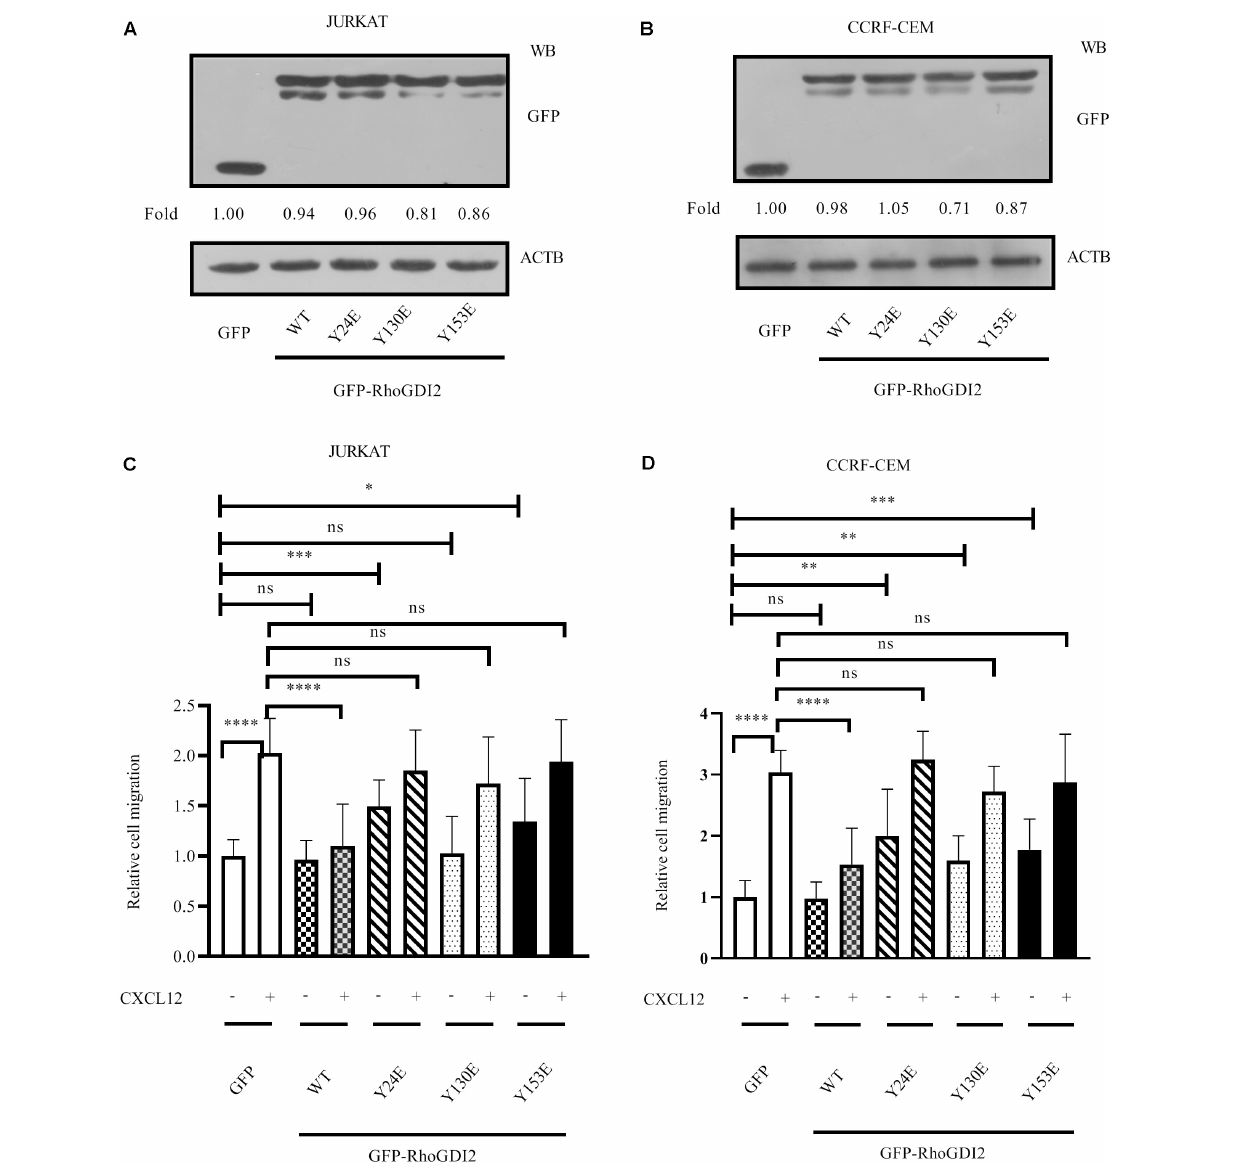
FIGURE 3 | Phosphorylation of RhoGDI2 Tyr 24, 130, or 153 recovered CXCL12-mediated ALL migration. JURKAT (A) or CCRF-CEM (B) cells were infected with lentivirus containing nucleotides expressing GFP-RhoGDI2-WT, Y24E, Y130E, or Y153E, and the overexpression levels of WT or mutated RhoGDI2 were detected 48 h after infection by Western blot, using GFP antibody. (C,D) Transfected cells were used in the transwell assay. Each experiment was repeated at least three times. Western blot bands were analyzed using Image Pro Plus 6.0, and fold changes of GFP, GFP-RhoGDI2-WT, or mutants were normalized according to ACTB. ACTB was used as the loading controls. * p < 0.05, ** p < 0.01, *** p < 0.001, **** p < 0.0001.